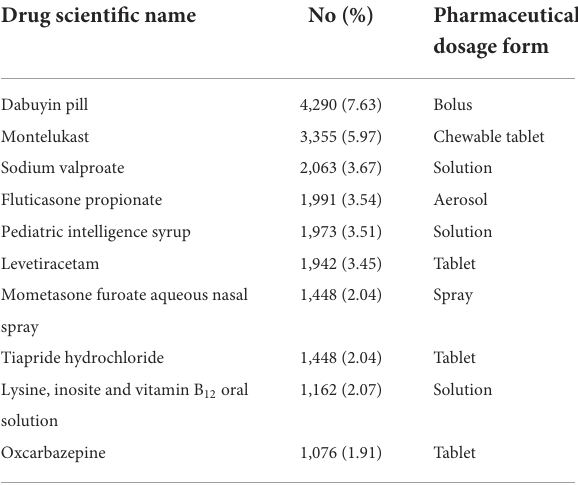
TABLE 3 Top 10 delivered